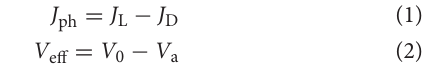
and Table 1 , the solution-processed DIBSQ:PC 71 BM SMBHJ